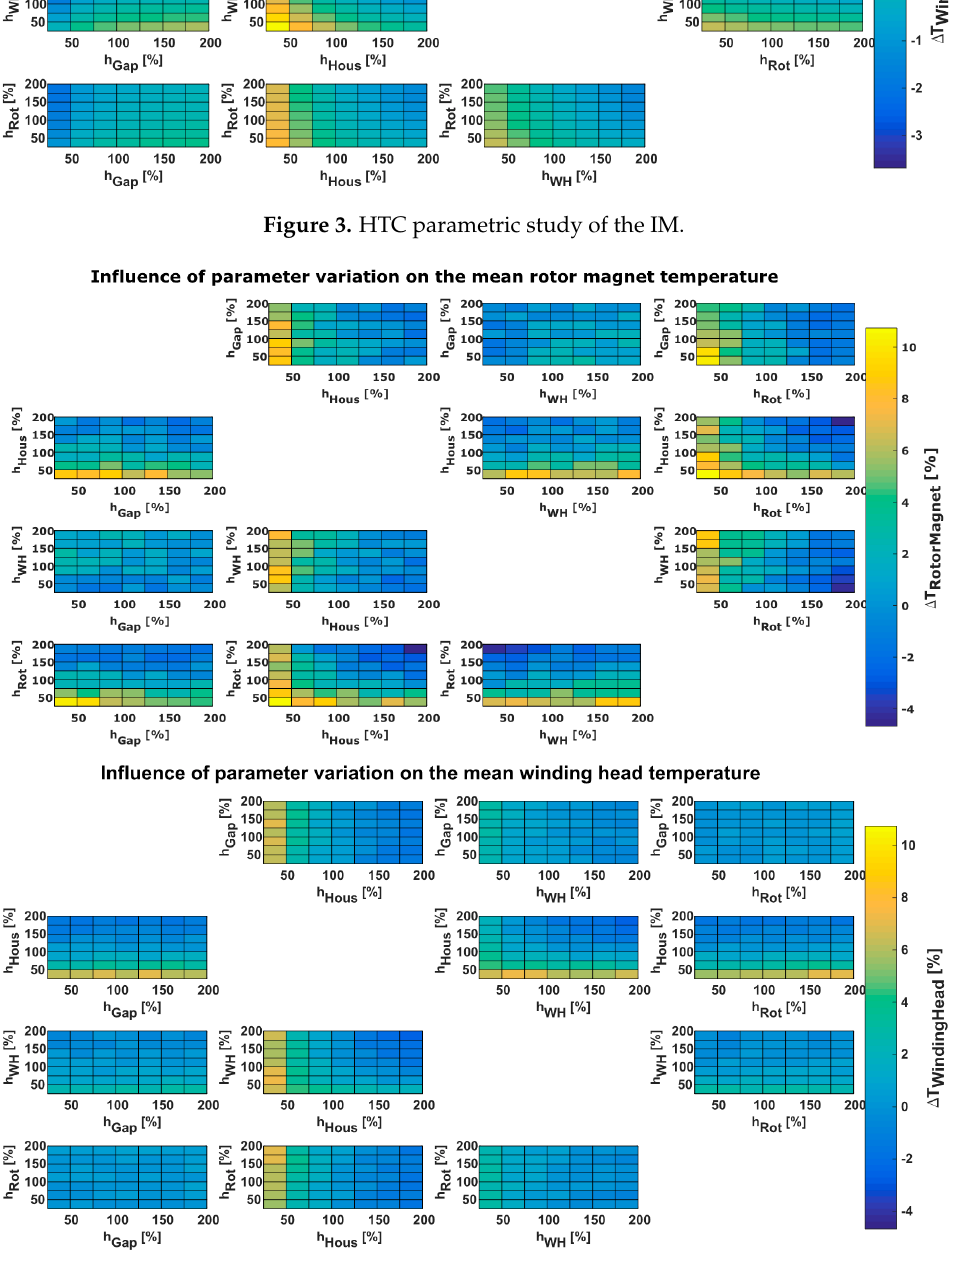
Figure 4. HTC parametric study of the PMSM.